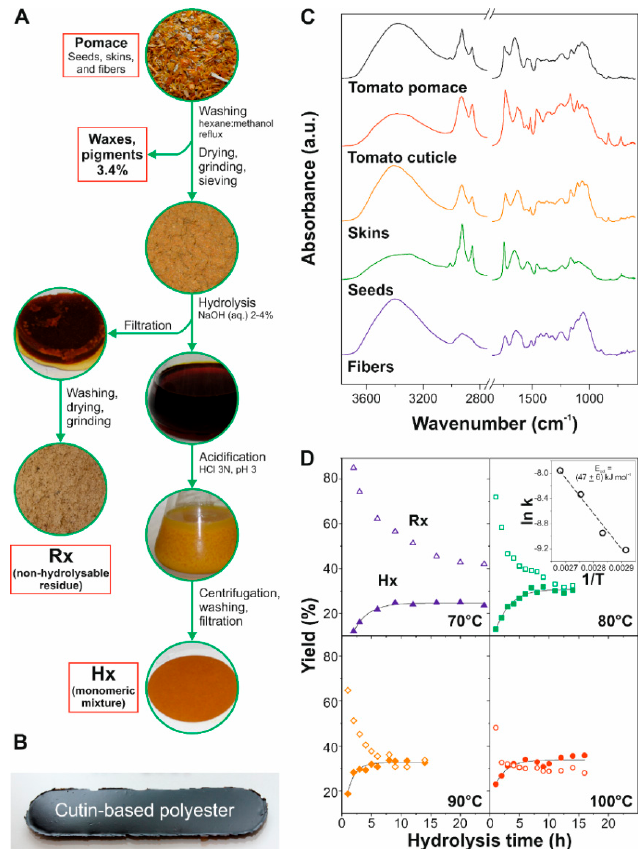
Figure 1. ( A ) Tomato pomace conditioning and processing to isolate the non-hydrolysable fraction (Rx) and the monomeric mixture (Hx). ( B ) Picture of a typical cutin-based film. ( C ) Infrared spectra of fibers, seeds, skins, tomato cuticle, and tomato pomace. ( D ) Recovery of the non-hydrolysable (Rx, empty symbols) and monomer mixture (Hx, filled symbols) in the alkaline hydrolysis of tomato pomace as a function of temperature and reaction time. The inset shows the ln k versus 1/T plot that allows the calculation of the activation